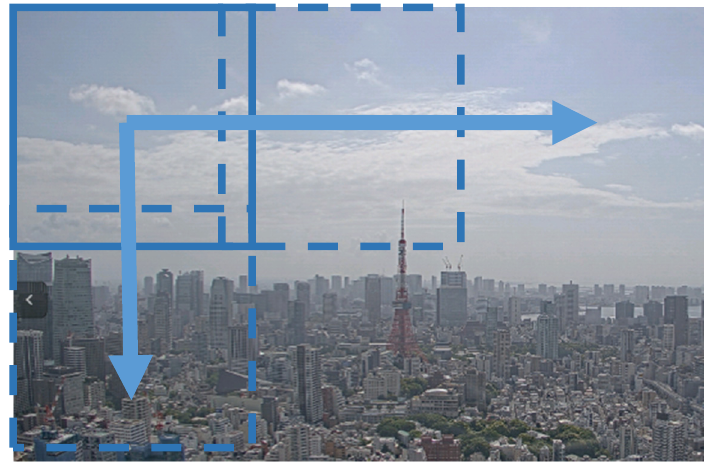
Figure 3. 4K image input.